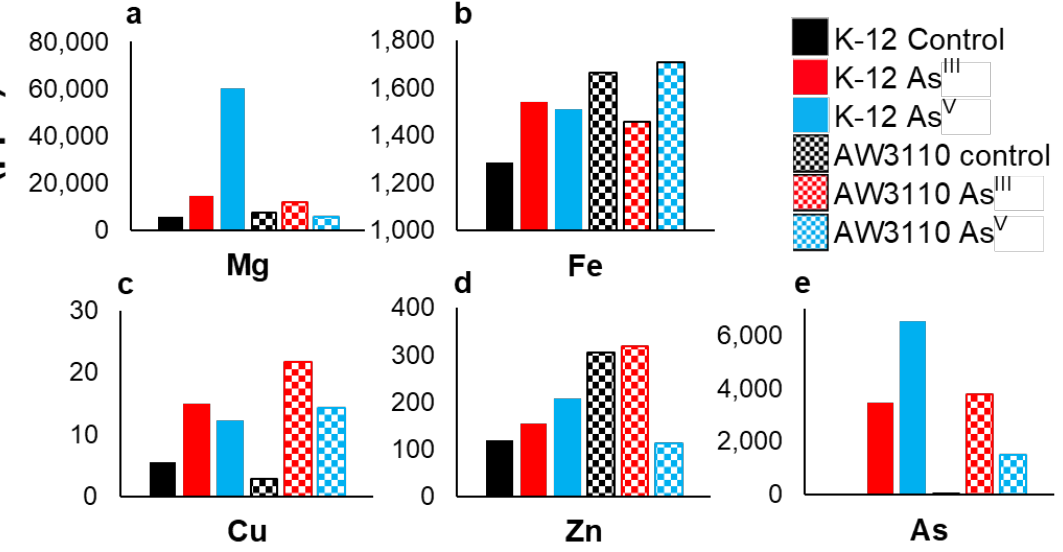
Figure 4. Total intracellular soluble metal. Pooled soluble fractions for K-12 (solid fill) and AW3110 (checkerboard) growths analyzed by ICP-MS for magnesium ( a ), iron ( b ), copper ( c ), zinc ( d ), and arsenic ( e ). As V treatment is shown in cyan, As III treatment is in red, and control is in black. The concentration is given above each sample in ppb.